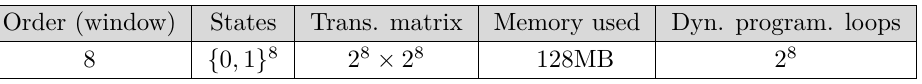
Table 2: Summary of implementation of the Markov chain model for entropy estimation. Order